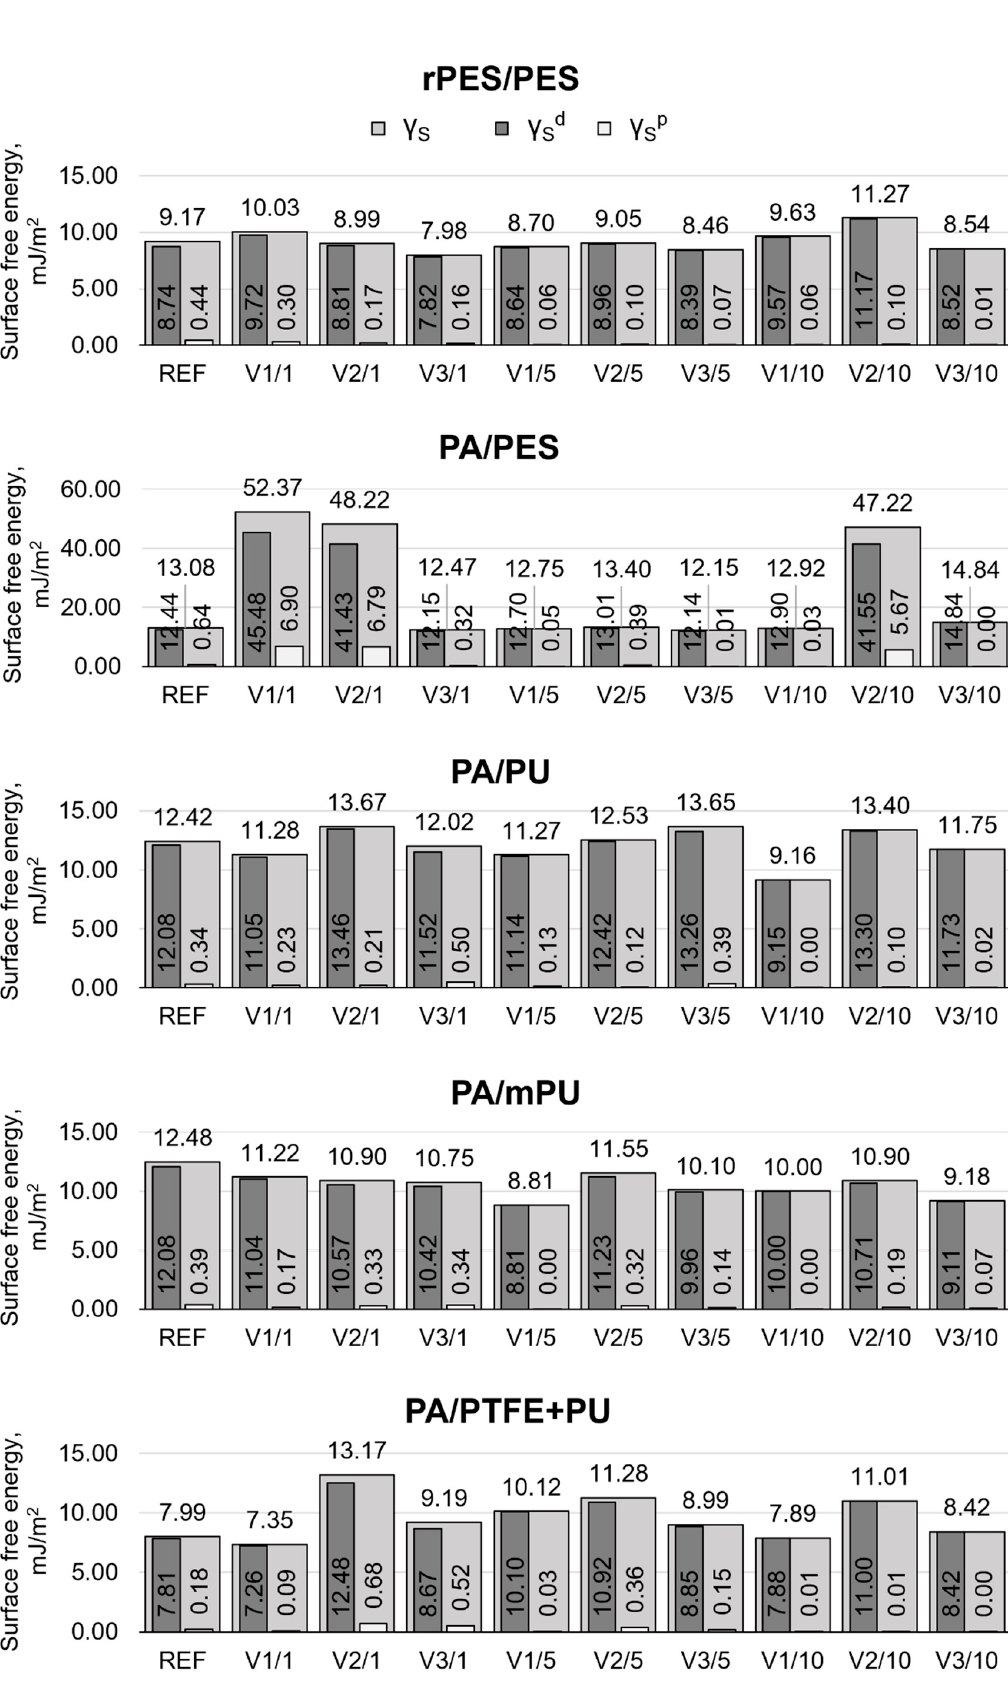
Figure 7. The average values of surface free energy ( γ S ) and its components, γ Sd and γ Sp .